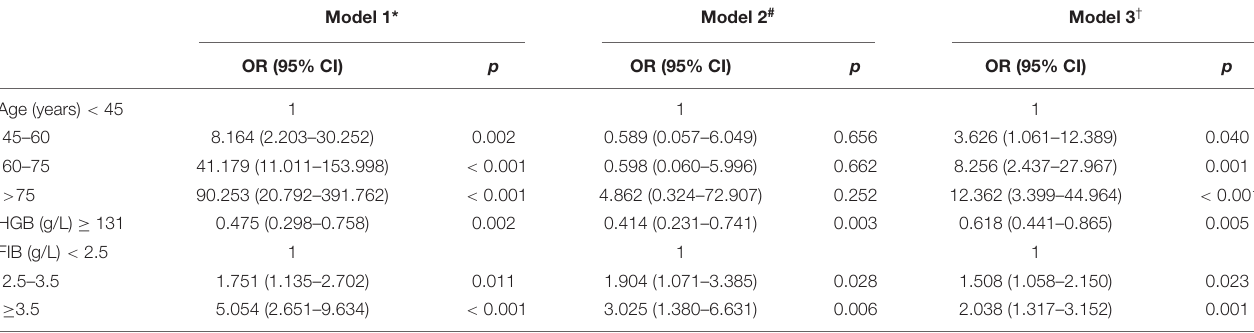
TABLE 5 | Logistic regression analysis for influencing factors for combined CAD and cancer.